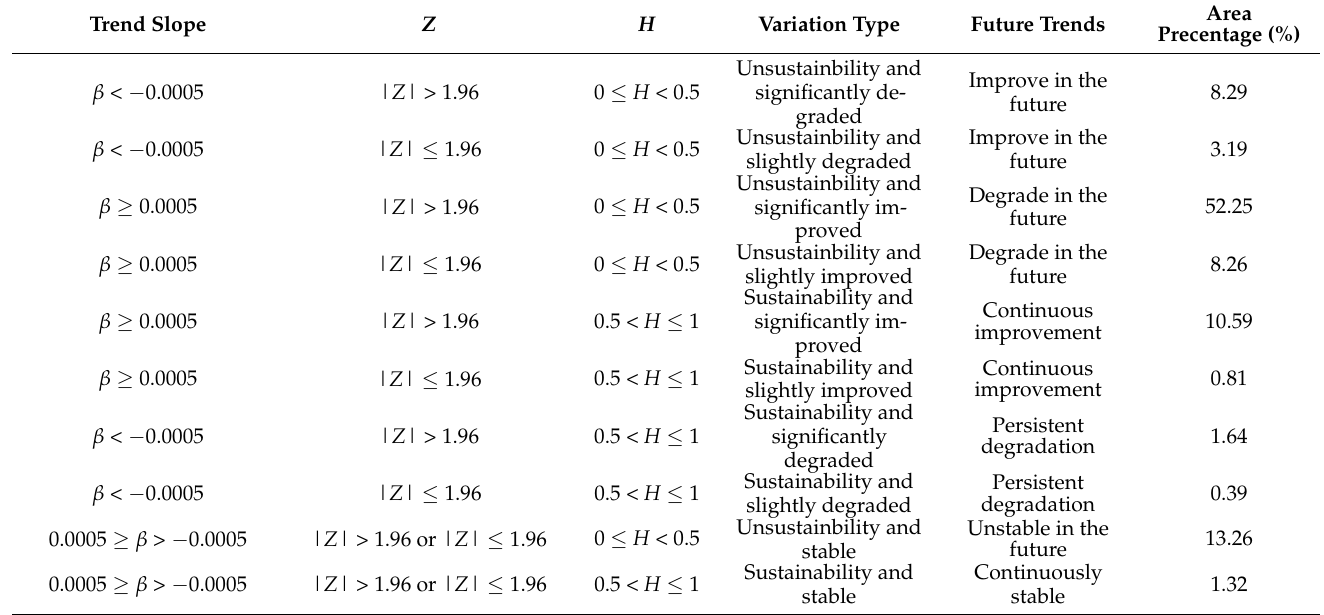
Figure 7. Future trends of vegetation in the UWNR. ( a ) Sustainability of the NDVI. ( b ) Future trends of vegetation. ( c ) Future trend under different vegetation types. ( d ) Future trend of vegetation in different elevation zones. ( e ) Future trend of vegetation in different slope zones. Note: IPV-F represents that vegetation will change from a degradation trend to an improvement trend in the future, IPV-C represents that vegetation will continue to improve in the future, ST-C represents that the continuous stability of vegetation, UST-F represents that unstable in the future, DEG-C represents that vegetation will continue to degenerate in future, and DEG-F represents that vegetation will change from an improvement trend to a degradation trend in the future. Table 4. NDVI trend and Hurst index in the UWNR from 1982 to 2020.